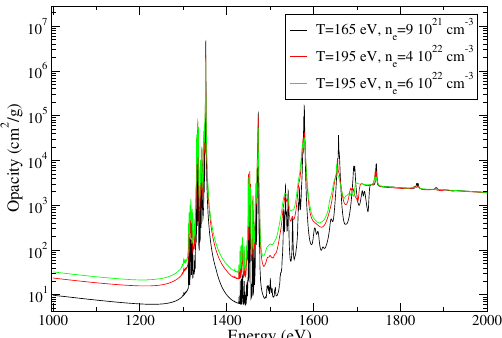
Figure 10. Magnesium opacity computed by SCO-RCG at T = 165 eV, n e = 9 × 10 21 cm − 3 , T = 195 eV, n e = 4 × 10 22 cm − 3 and T = 195 eV, n e = 6 × 10 22 cm − 3 .